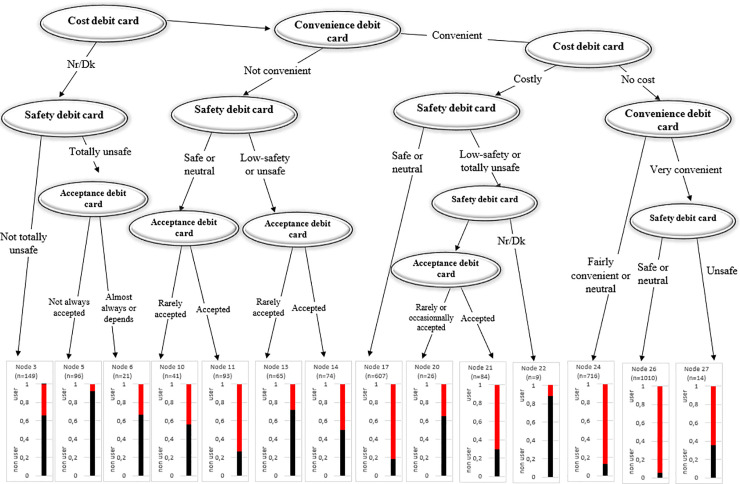
Tree: Debit card use.